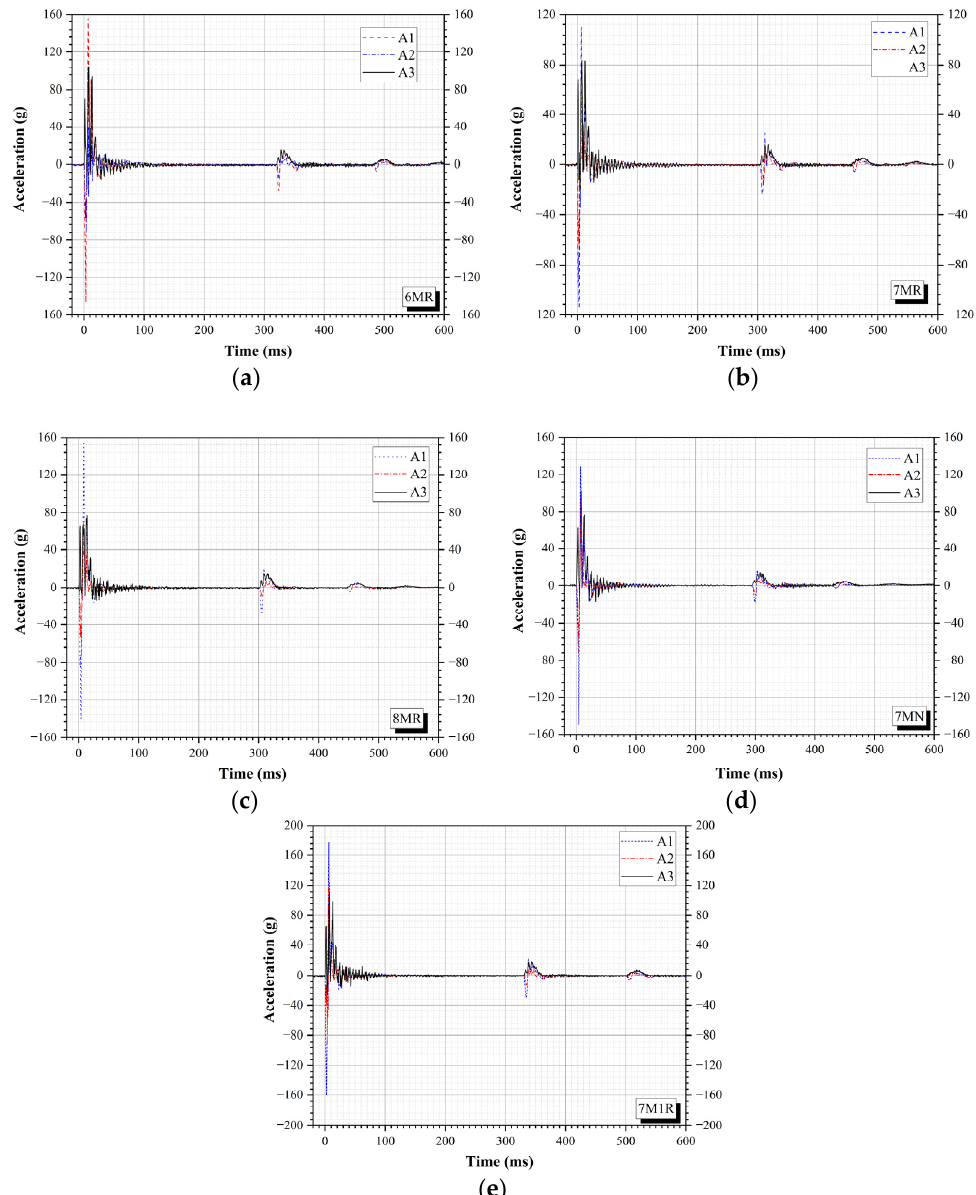
Figure 6. Acceleration-time histories of the ( a ) 6MR specimen, ( b ) 7MR specimen, ( c ) 8MR specimen, ( d ) 7MN specimen, and ( e ) 7M1R specimen. ( d ) 7MN specimen, and ( e ) 7M1R